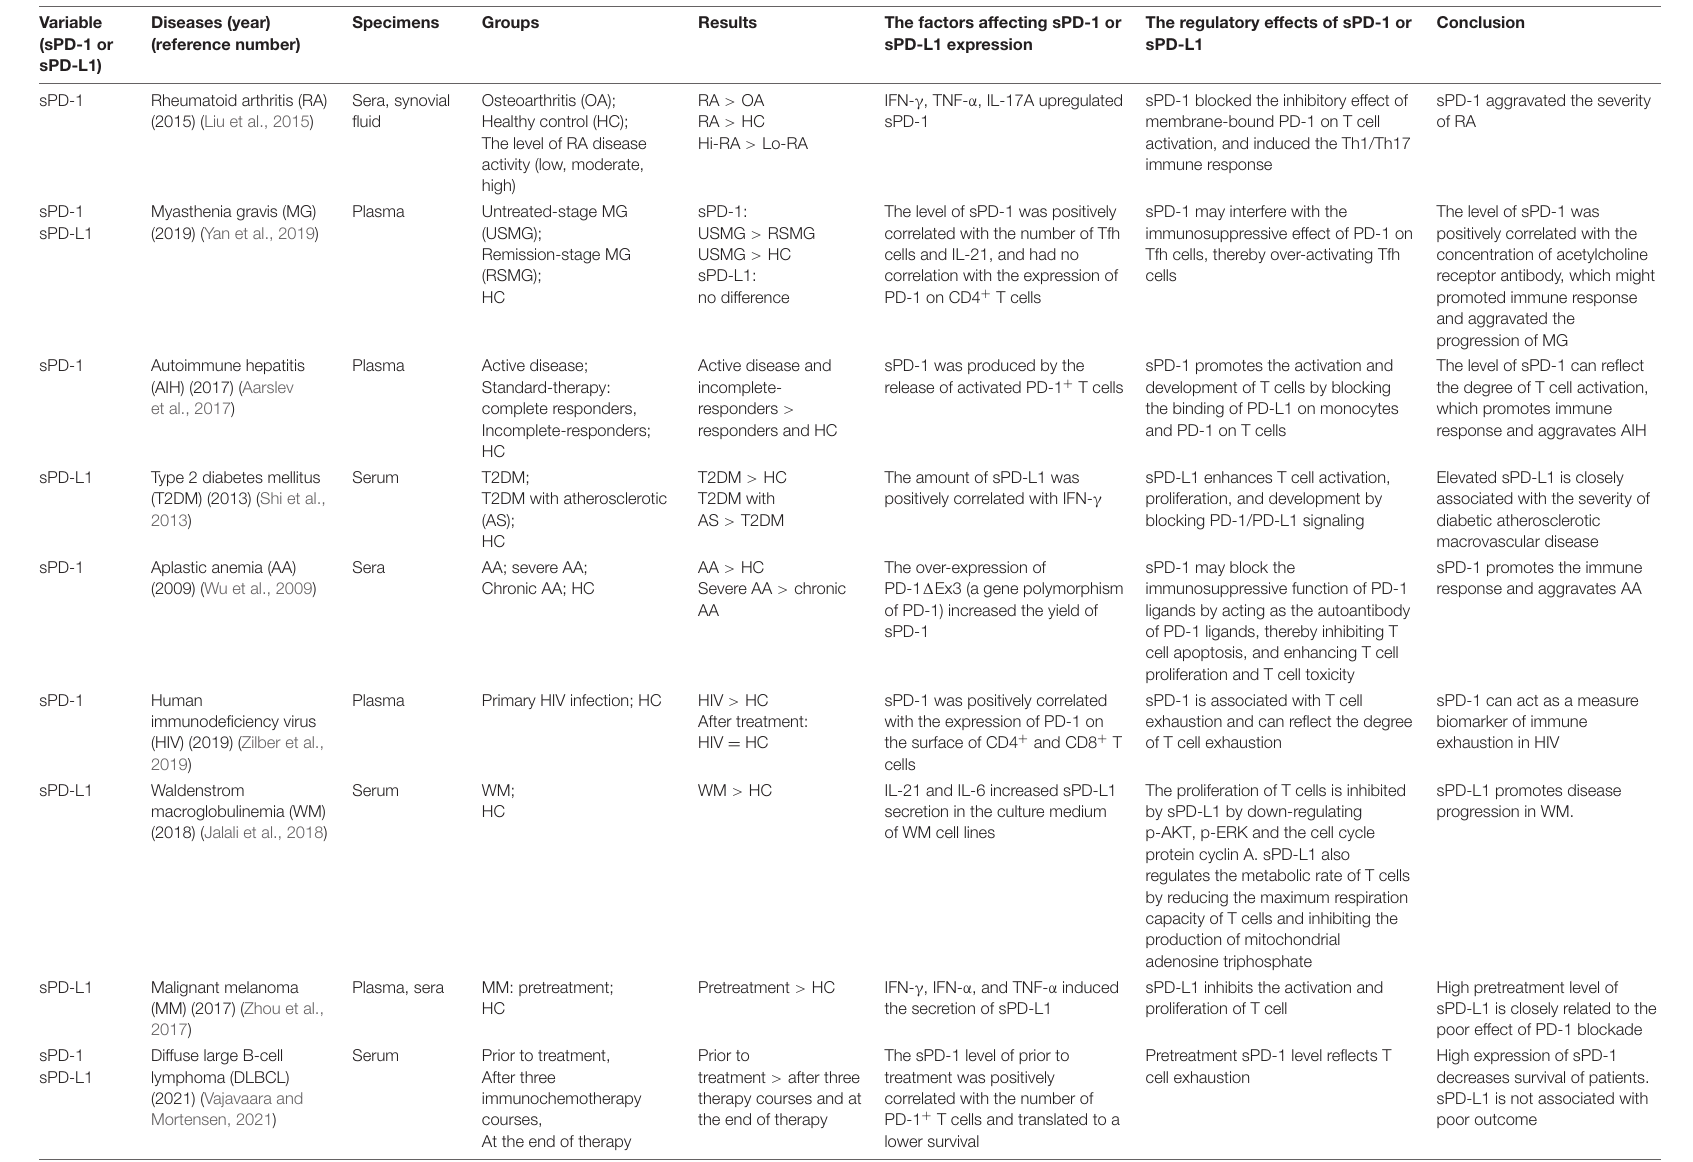
TABLE 1 | The studies of sPD-1 and sPD-L1 in autoimmune diseases and tumors. Variable (sPD-1